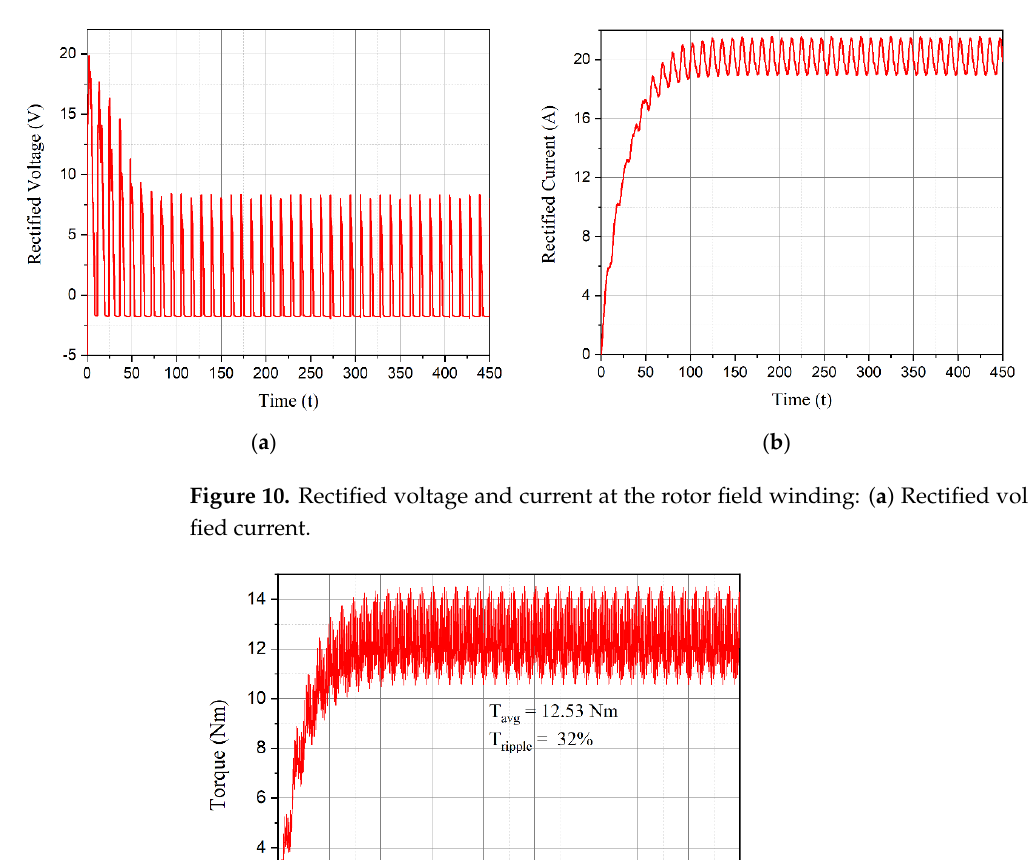
Figure 9. Induced voltage and current at the rotor harmonic winding: ( a ) Induced voltage; ( b ) In- duced current.